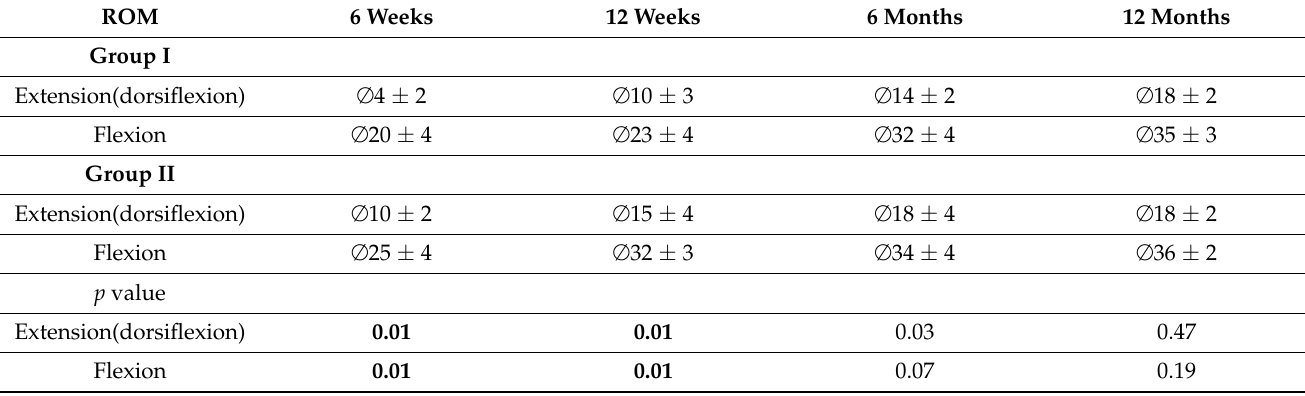
Table 5. Range of Motion at each single follow-up exam. Results are given as ∅ mean and +/ − standard deviation. Group I was treated by DePuy Synthes one third semitubular, Group II with the IlluminOss ® Photodynamic Bone Stabilization